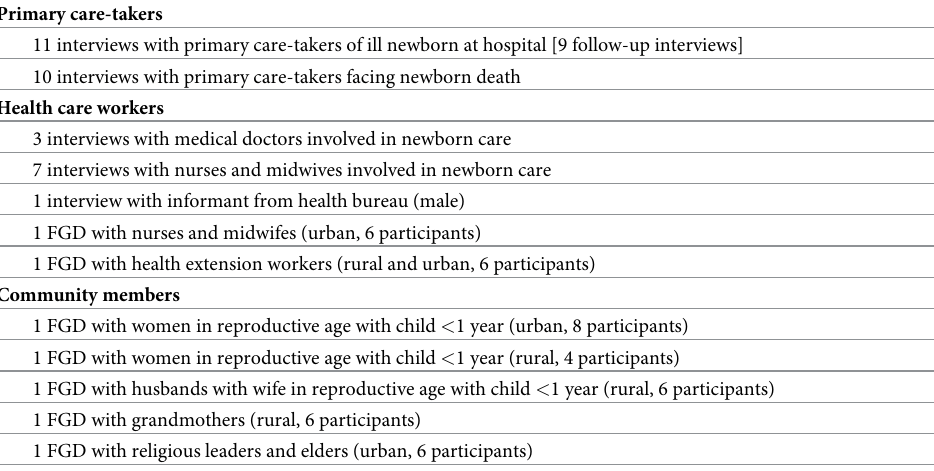
Table 1. Participants of in-depth interviews and focus group discussions